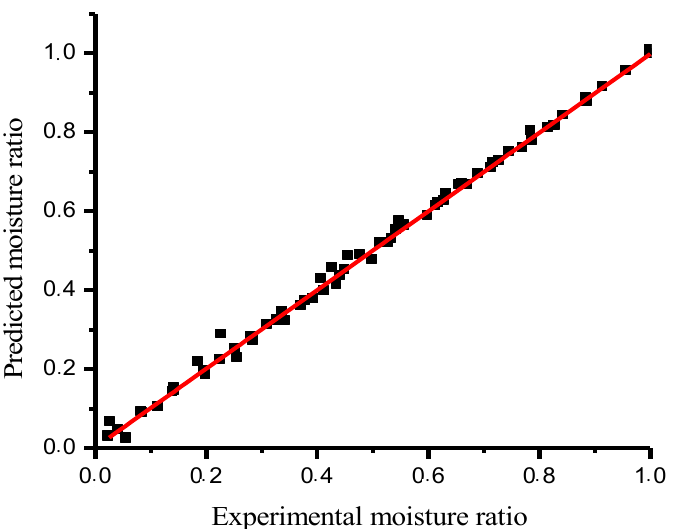
Figure 5. Relationship between moisture ratios as predicted by Midilli-Kucuk model and the observed moisture ratio of the Arbutus unedo L. at temperatures (R² = 0.9998).